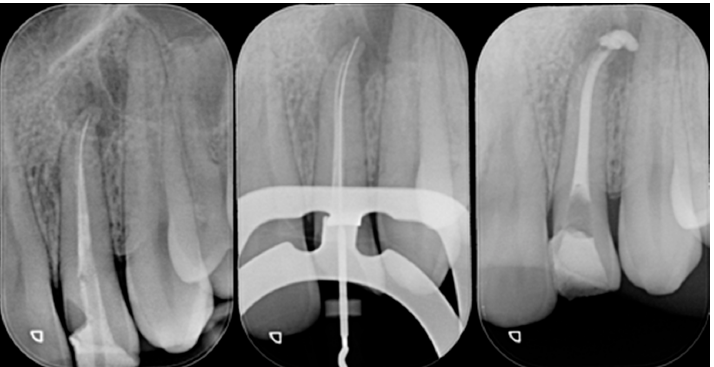
Figure 21. Initial x-ray, during and after endodontic retreatment. Reprinted from Restauri diretti nei settori anteriori, G. Paolone, S. Scolavino, © 2021, with permission from Quintessence Publishing Italy.